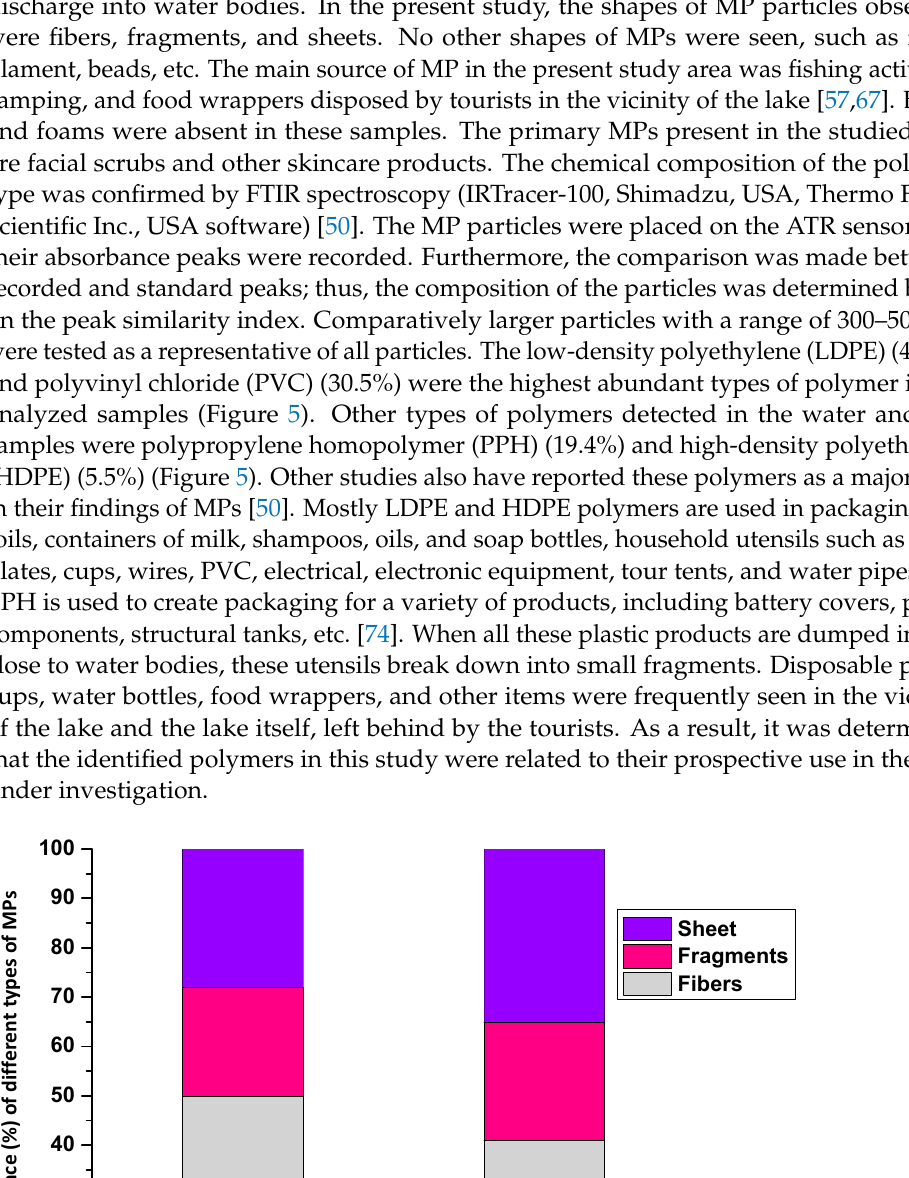
Figure 5. Detected polymer types in the current study. 4. Conclusions The main findings of the present study showed that MPs have reached into higher altitudes in remote areas due to tourism activities. A considerable amount of MP particles was evident in the surface water of the Lake Mahodand and a trout fish in Kalam, Pakistan. Fibers were the most abundant types of MPs both in surface water and fish